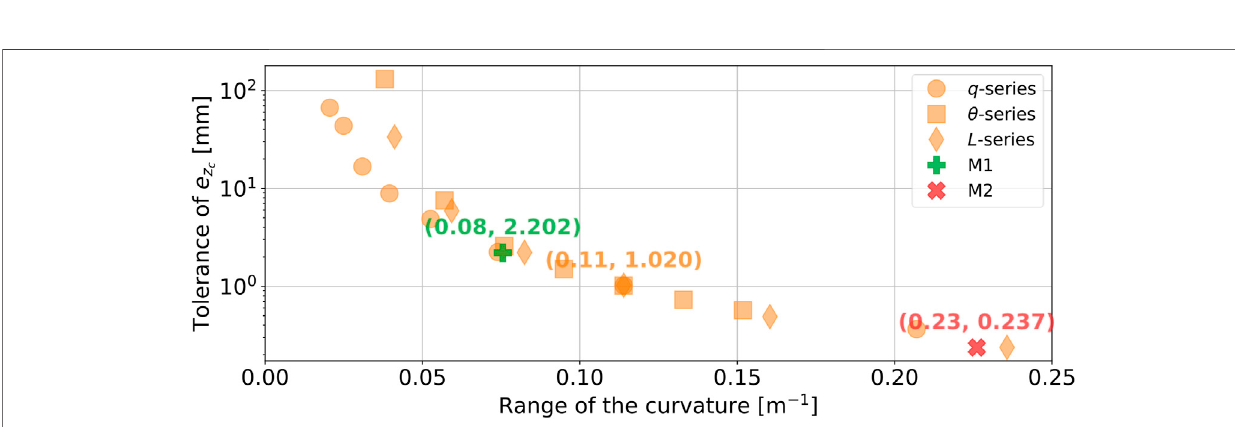
Frontiers in Physics |